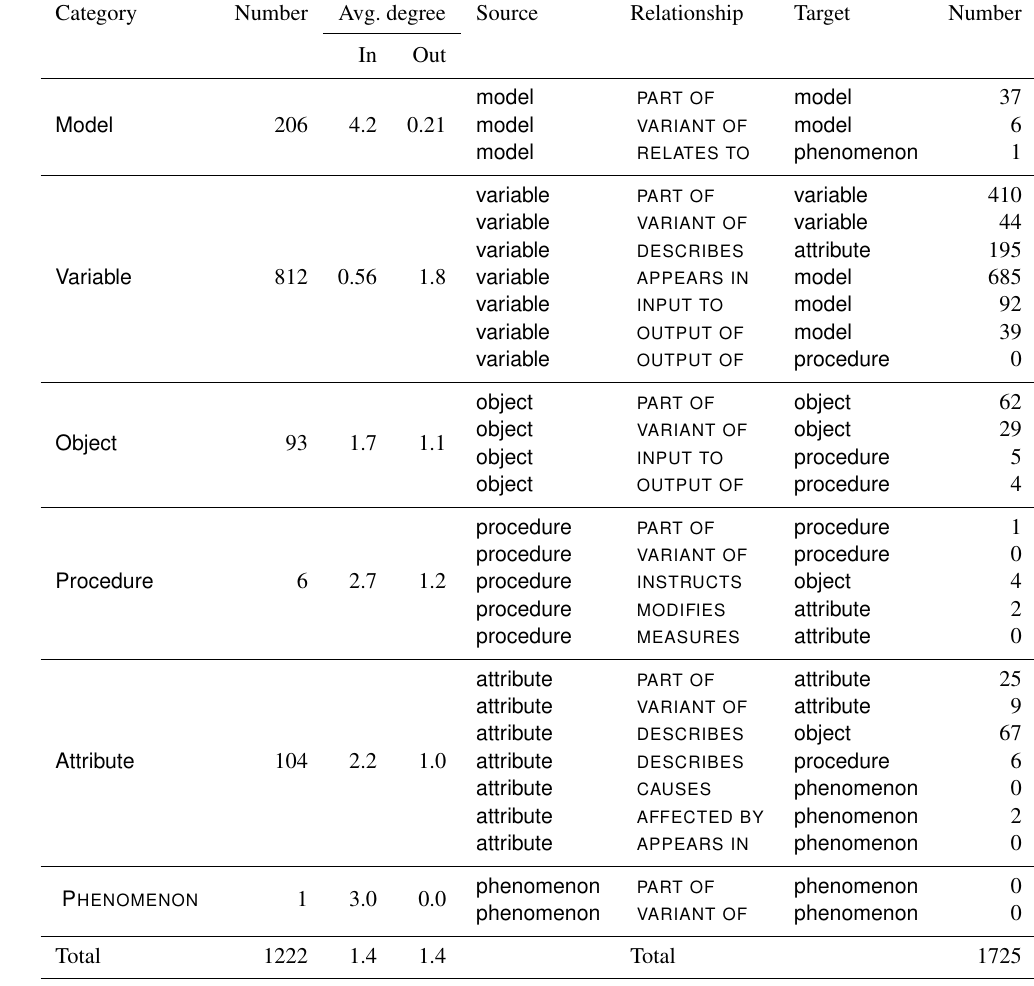
Table 4. Breakdown of database content node and edge